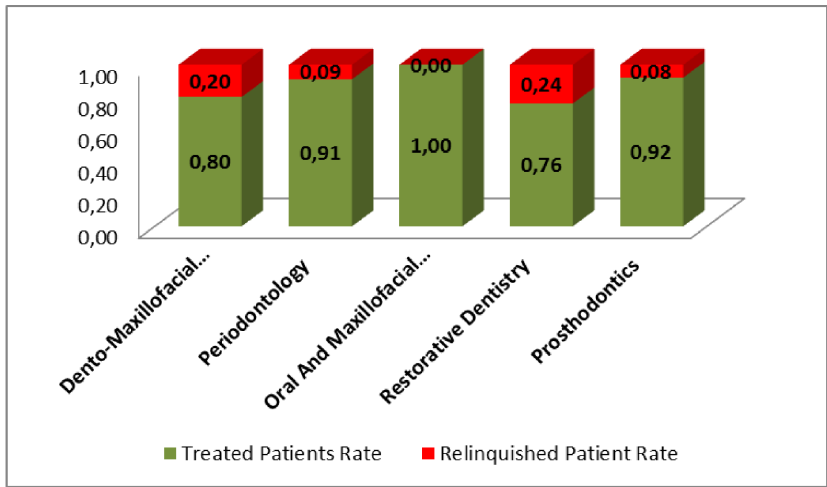
Figure 8. The real system - rate comparison of treated and relinquished patients in the dental hospital (Tekin & Erol,